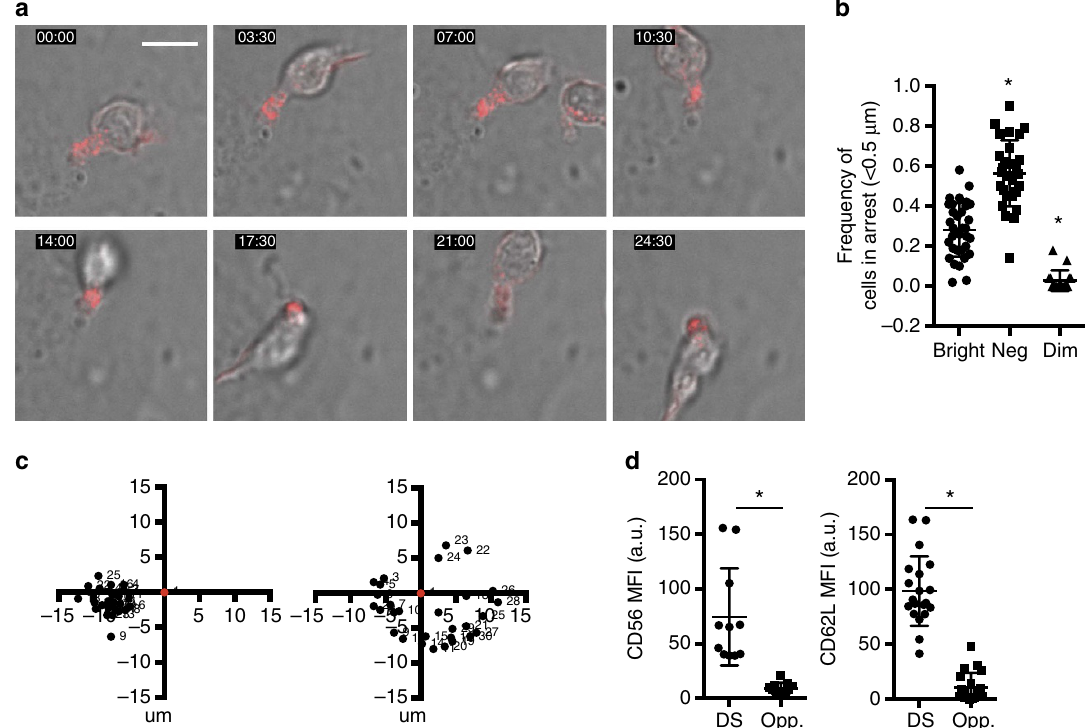
Figure 2 | Human NK cells conjugate to stromal cells through a CD56- and CD62L-enriched structure. CD56 bright NK cells were purified and incubated on EL08.1D2 stromal cells for 4h. Cells were imaged as in Fig. 1 in the presence of anti-CD56 (red) antibody. ( a ) A single CD56 bright NK cell highlights polarization of CD56 and adhesion to stromal cells. Scale bar, 10 m m. See also Supplementary Movie 4. ( b ) Cells were tracked and the frequency of cells in arrest for each condition was measured ( n ¼ 30). Data are represented as mean ± s.d. P o 0.0001 by ordinary one-way ANOVA. * P o 0.05 by post hoc Tukey’s comparison with CD56 bright condition. ( c ) Degrees of rotation of a CD56 bright NK cell incubated on anti-CD56 antibody (left) or EL08.1D2 stromal cells (right) and imaged with confocal microscopy. The anchoring point is shown in red and consecutive live-cell frames are shown in black. ( d ) Accumulation of CD56 (left) or CD62L (right) in CD56 bright NK cells at the point of contact (DS) or distal site (opp.) when incubated on EL08.1D2 stromal cells and imaged by live confocal microscopy. Data are represented as mean ± s.d. * P o 0.05 by Student’s unpaired t